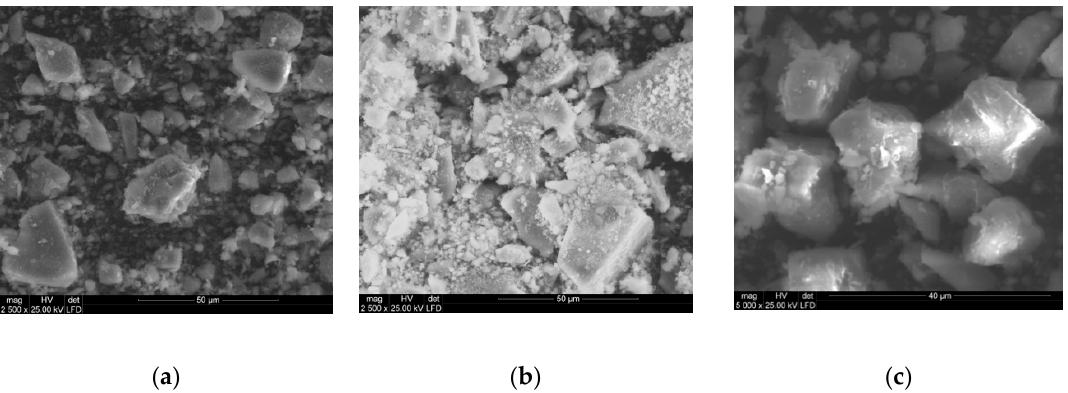
Figure 5. Examples of SEM images of copper ore particles comminuted in a planetary ball mill type PM 100: ( a )—carbonate, ( b )—sandstone, ( c )—shale ore.